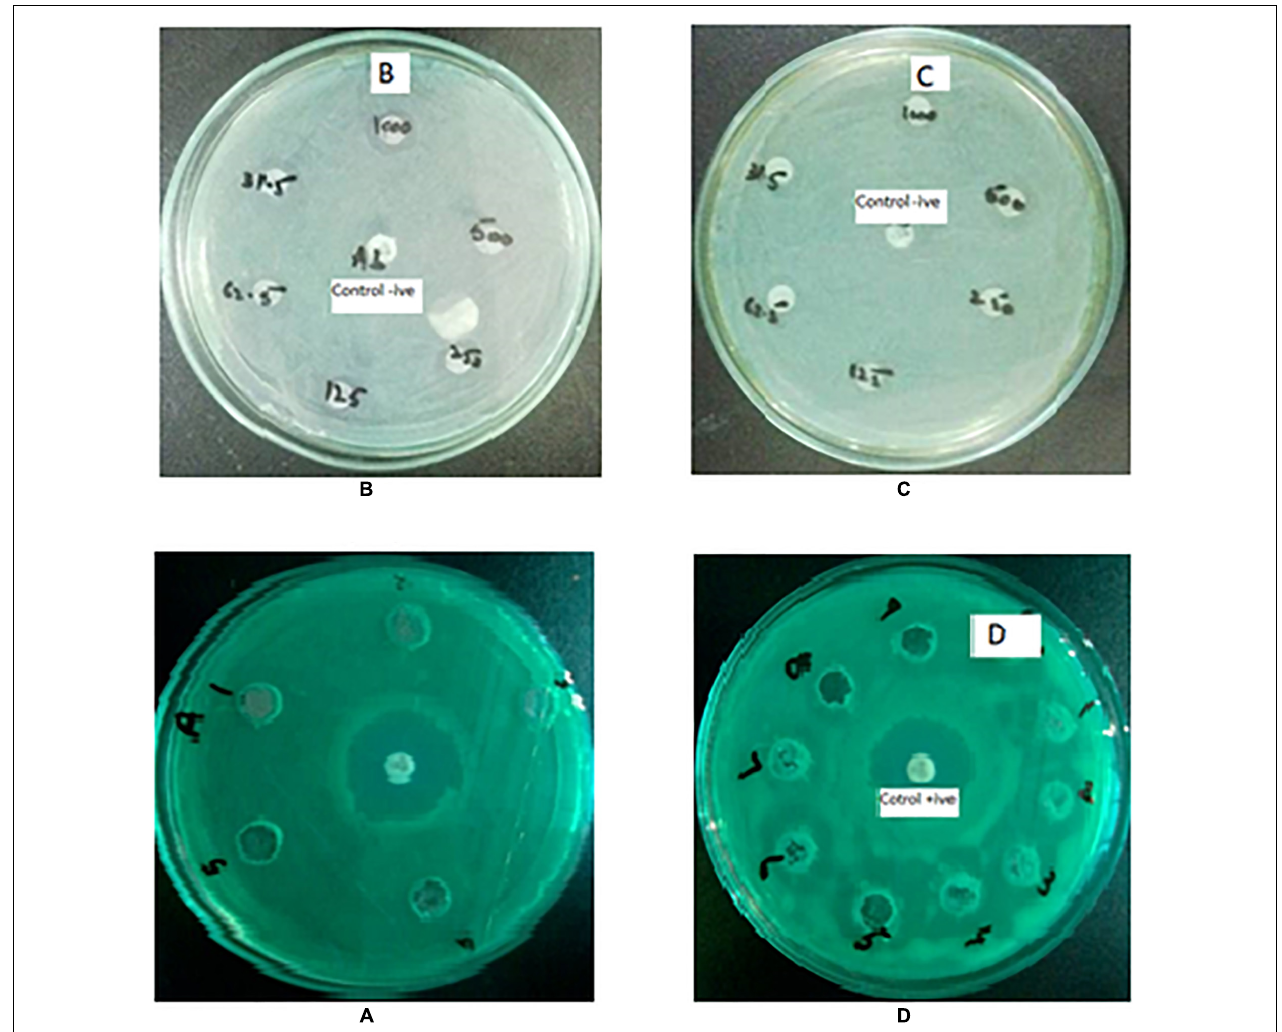
FIGURE 5 | (A–D) Antibacterial effects against P. aeruginosa (A) Pure NiO nanoparticles with no antibacterial activity, antibiotic aztreonam in middle was used as positive control. (B–D) Zone of inhibition produced by Al-doped NiO nanoparticles at x = 5, 10, and 15 wt.%, respectively. TABLE 3 | Estimation of zone of inhibition (ZOI) of Ni 1 − x Al x O; x = 5, 10, 15, 20, 25, and 30 wt.% nanoparticles. Ni 1 − x Al x O Zone of inhibition (mm) x 1000 µ (wt.%)